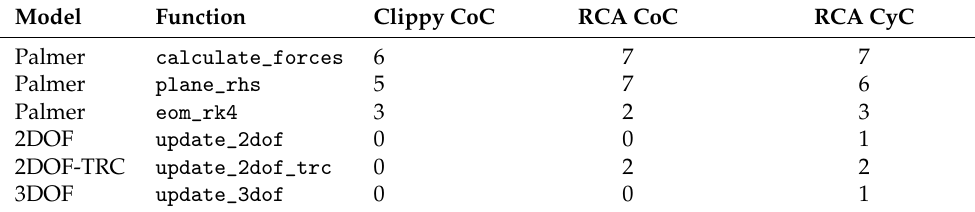
Table 2. The static analysis tools Clippy and rust-code-analysis generated metrics for cognitive complexity (CoC) and cyclomatic complexity (CyC) for each of the functions in the Palmer and the simple